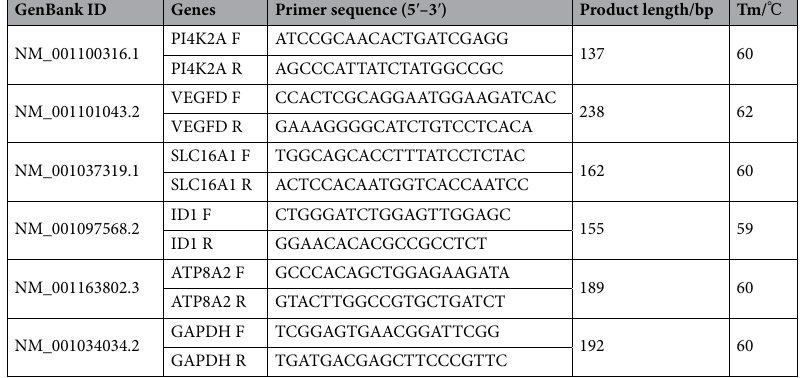
Table 4. Primer sequence and annealing